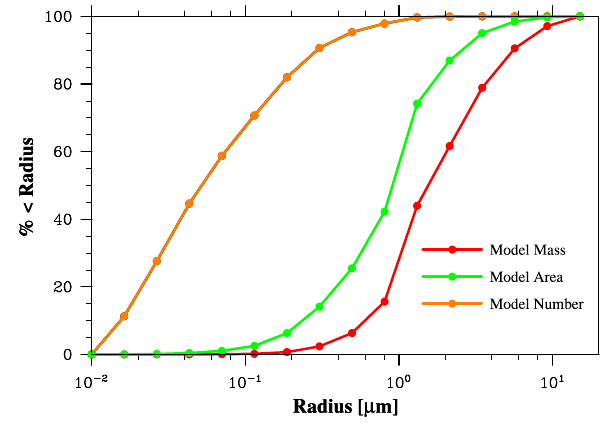
Fig. 18. Percentage of number, cross-sectional area, and mass size distribution less than a particular radius in the dry radius range from 0.01–15.2µm. The number and mass concentration are for bottom layer. The cross-sectional area is calculated for humidified particles in the whole column. These are the size distributions at Midway Island in June 2006 using the CMS source function and a solubility factor of 0.5. Table 5. Monthly-averaged number concentration with radius 0.01– 4µm and fraction of particles with radius of 0.01–0.05µm at Mid- way Island in June